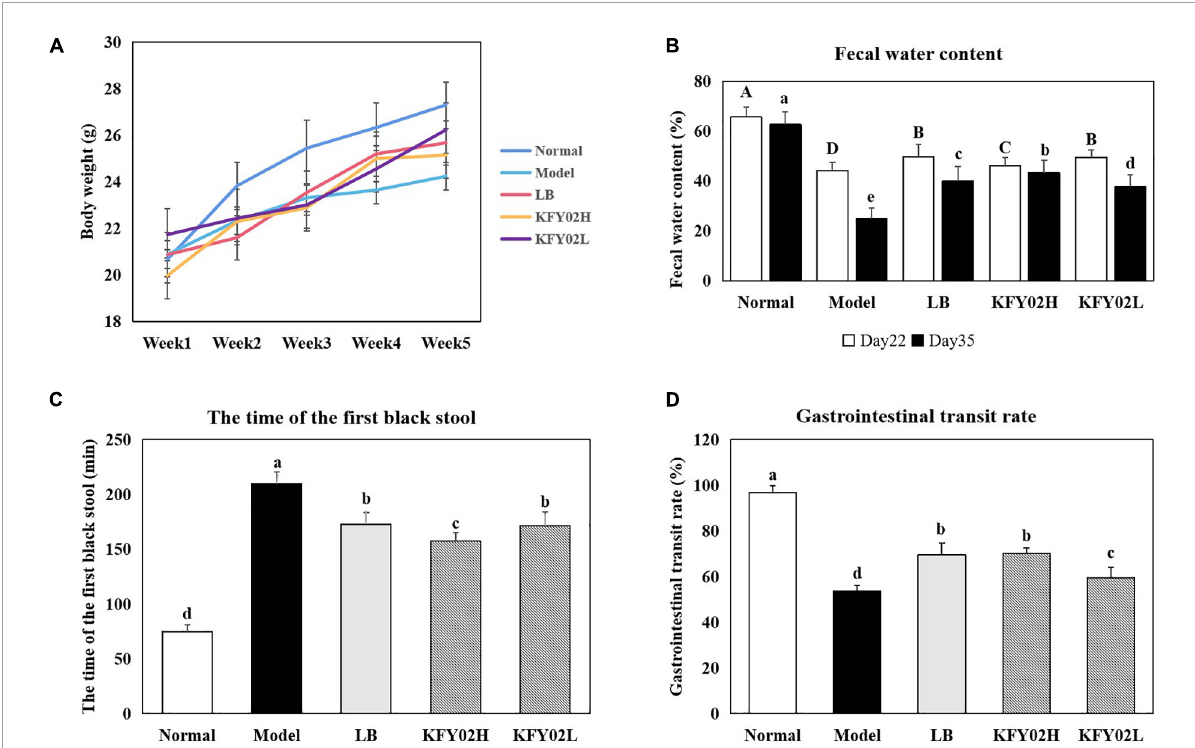
FIGURE2 Effect of LP-KFY02 on constipation in mice. (A) Body weight; (B) fecal water content; (C) the time of the first black stool; (D) gastrointestinal transit rate. Data are means ± standard deviations. a - e Different superscript letters within a column correspond to significant differences ( p < 0.05). LB: mice administered with 1 × 10 9 CFU/kg LB, KFY02H: mice administered with 1 × 10 9 CFU/kg LP-KFY02, KFY02L: mice administered with 1 × 10 8 CFU/kg